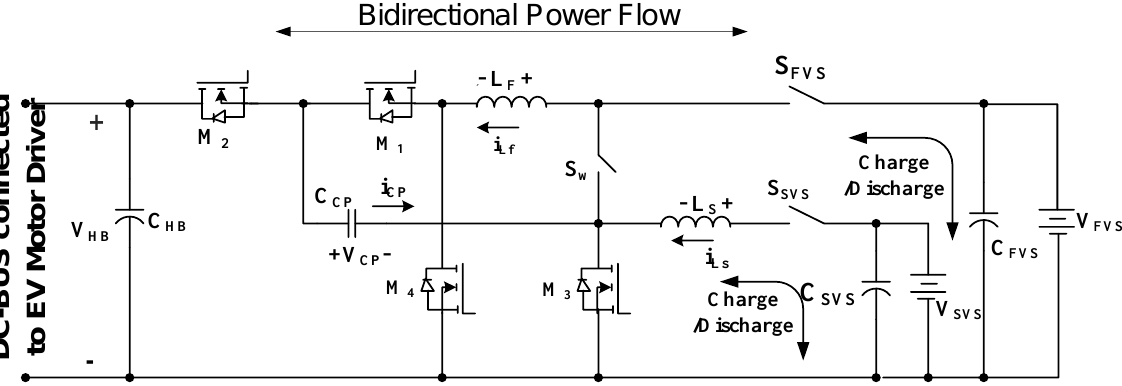
Figure 2. Dual-battery energy storage in BDC architecture. 2.1. Dual Low-Voltage Sources Powering Mode Switches ( S FVS and S SVS ) are turned ON. Dual low voltage sources ( V FVS , V SVS ) provide energy to connected loads and the DC-bus, as shown in Figure 3a. M 3 and M 4 switches on the bottom side are controlled by active switching with a 180 ◦ phase shift angular position, whereas M 1 and M 2 switches on the top side are synchronous rectifiers. Four circuit stages are featured in Figure 4. Dual-sources low voltage powering mode steady-state waveforms with a duty ratio greater than 50%, as illustrated in Figure 3b, and the operation, can be stated briefly as follows. (a) Stage 1 [t 0 < t < t 1 ]: Time period at this point is (1 − D t )T s . As shown in Figure 4a, switches M 1 and M 3 are ON, whereas switches M 2 and M 4 are OFF. Voltage across the first inductor L f , which drops linearly from its original value, is represented by the differential between the charge pump voltage, V CP and the lower side voltage , V FVS . Voltage across the second inductor L s charged by the energy source, V SVS increases linearly. Characteristic equations in stage 1 in terms of voltage across the inductors L f and L s are denoted by Equations (1) and (2):